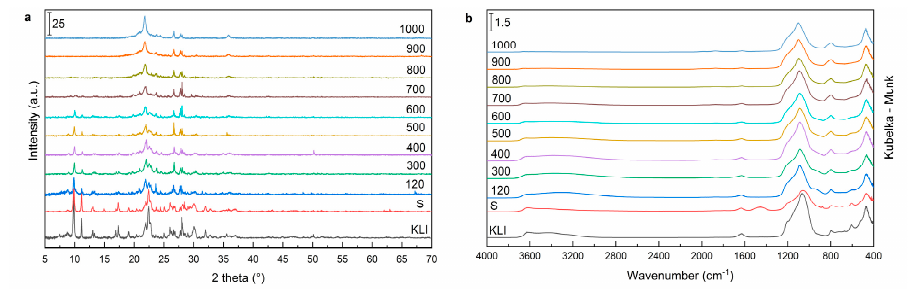
Figure 8. Powder di ff raction patterns ( a ) and DRIFT spectra ( b ) of calcined